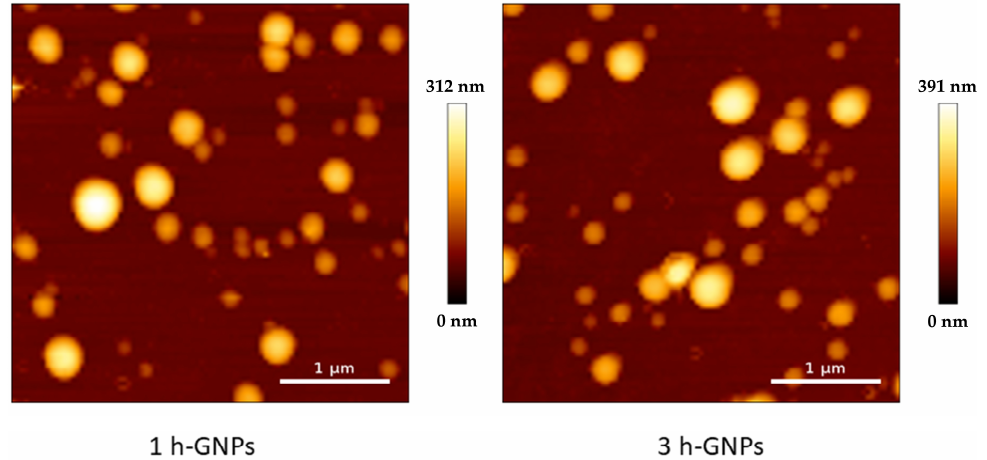
Figure 2. AFM height image of 1 and 3 h crosslinked GNPs measured in liquid at 37 °C, showing a number-based size of 217 ± 52 and 224 ± 65 nm.